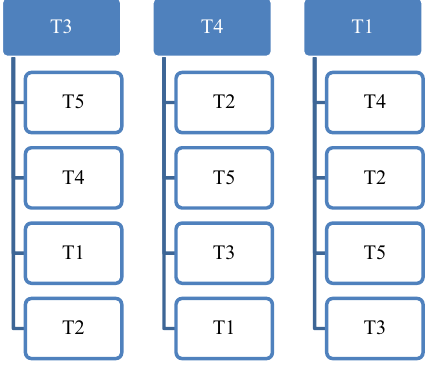
Fig. 2 Schematic of the research design and location of treatments and replications